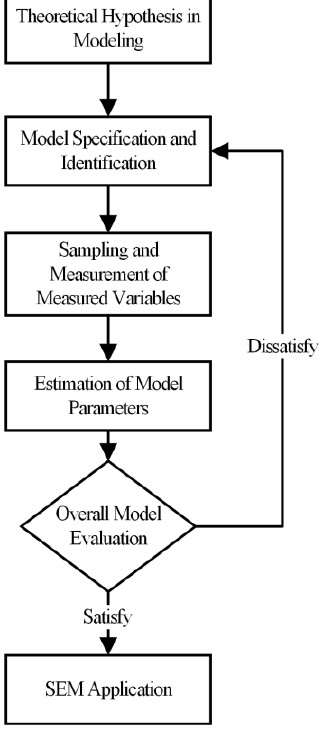
Figure 1. SEM calculation procedure.